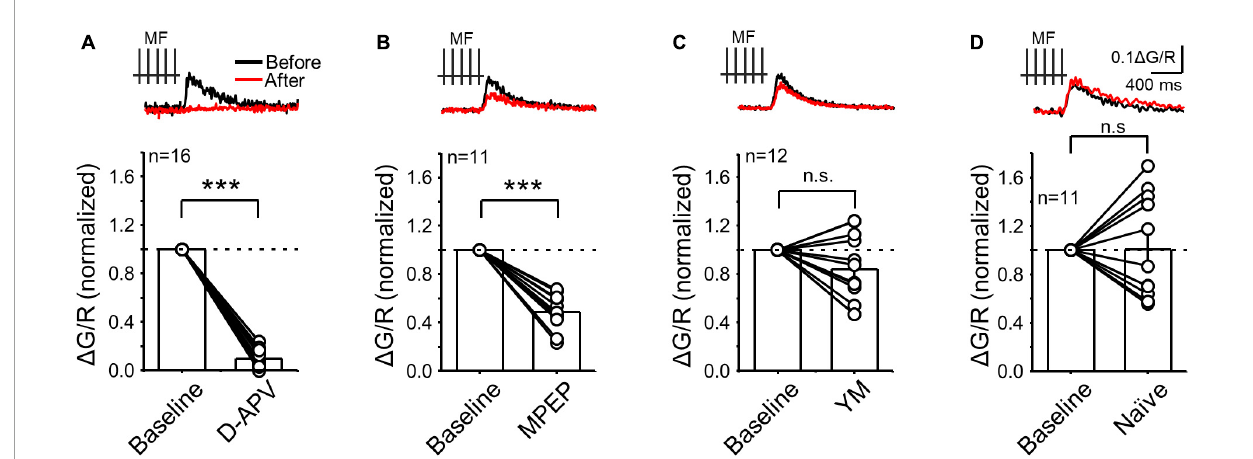
FIGURE3 NMDAR and mGluR5 but not mGluR1 contributed to postsynaptic calcium rise evoked during presynaptic MF burst activity. (A) Calcium signals induced by presynaptic stimulation (PRE) before and after bath application of the NMDAR antagonist D-APV (25 µ M). Representative traces (top) and summary plot of the averaged peak (cid:49) G/R before (normalized to baseline) and after drug application. (B–D) Same experimental design as in panel (A) but following application of the mGluR5 antagonist MPEP (4 µ M) (B) , the mGluR1 antagonist YM (1 µ M) and in naïve conditions (i.e., calcium signals monitored during 15–30 min in the absence of drug applications) to evaluate stability. Data are presented as mean ± SEM. *** p < 0.001, n.s. not